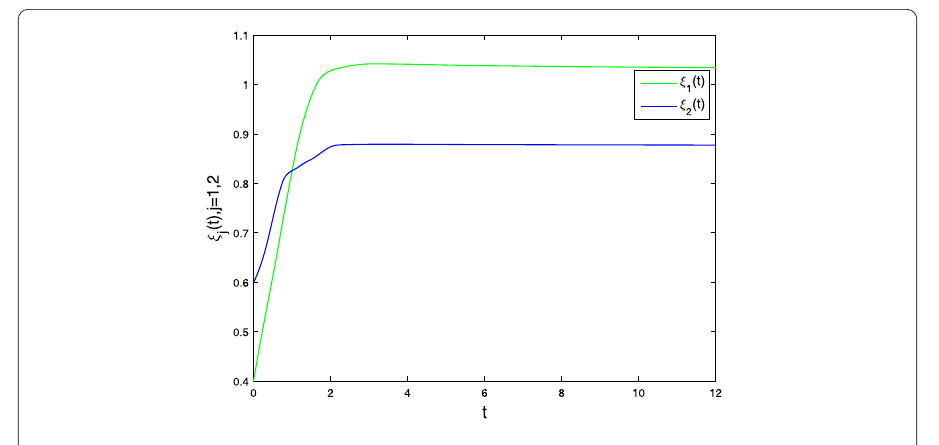
Figure 4 Time response curves of ξ 1 ( t ) and ξ 2 ( t )